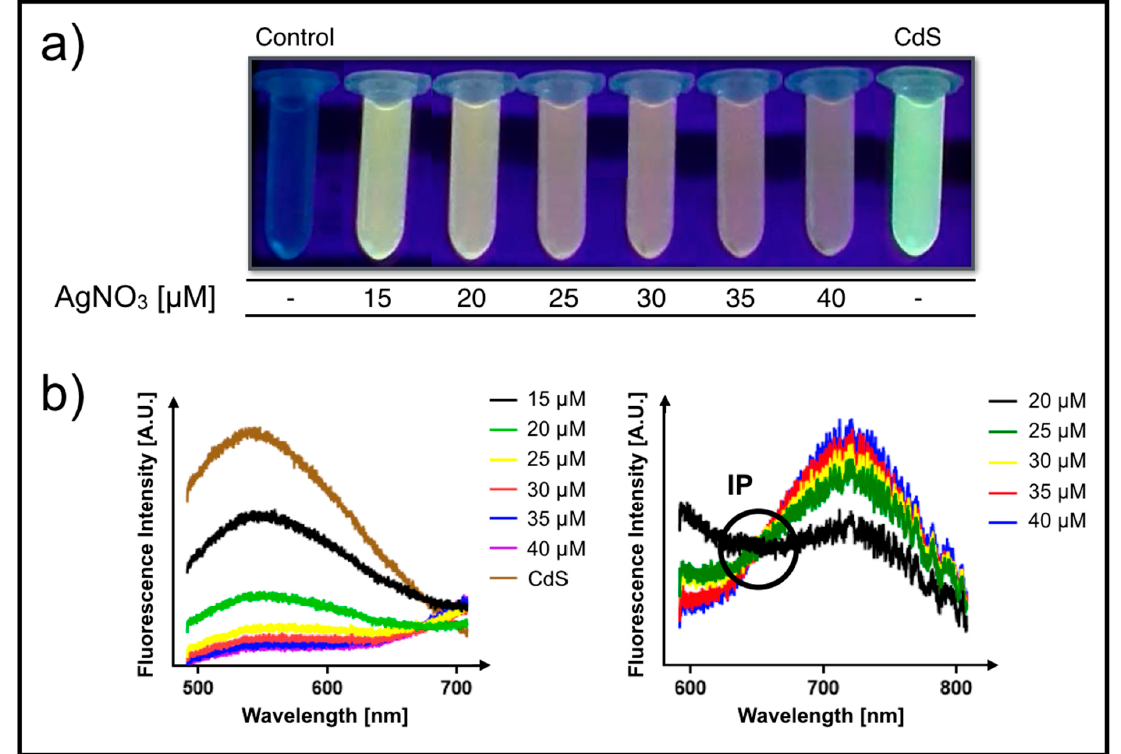
Figure 2. Biosynthesis of CdS Quantum Dots (QDs) in the presence of different AgNO 3 concentrations (15 to 40 µM). Negative control condition contains CdCl 2 (100 µM) in the absence of cysteine (no fluorescence). The positive control (CdS) was conducted without the addition of AgNO 3 . ( a ) Biosynthesis solutions obtained in the presence of different AgNO 3 concentrations exposed and not exposed to UV. Concentrations of reagents used in each reaction are indicated. ( b ) and ( c ) Fluorescence spectra of samples containing AgNO 3 at different concentrations. The isosbestic point (IP) is also shown.